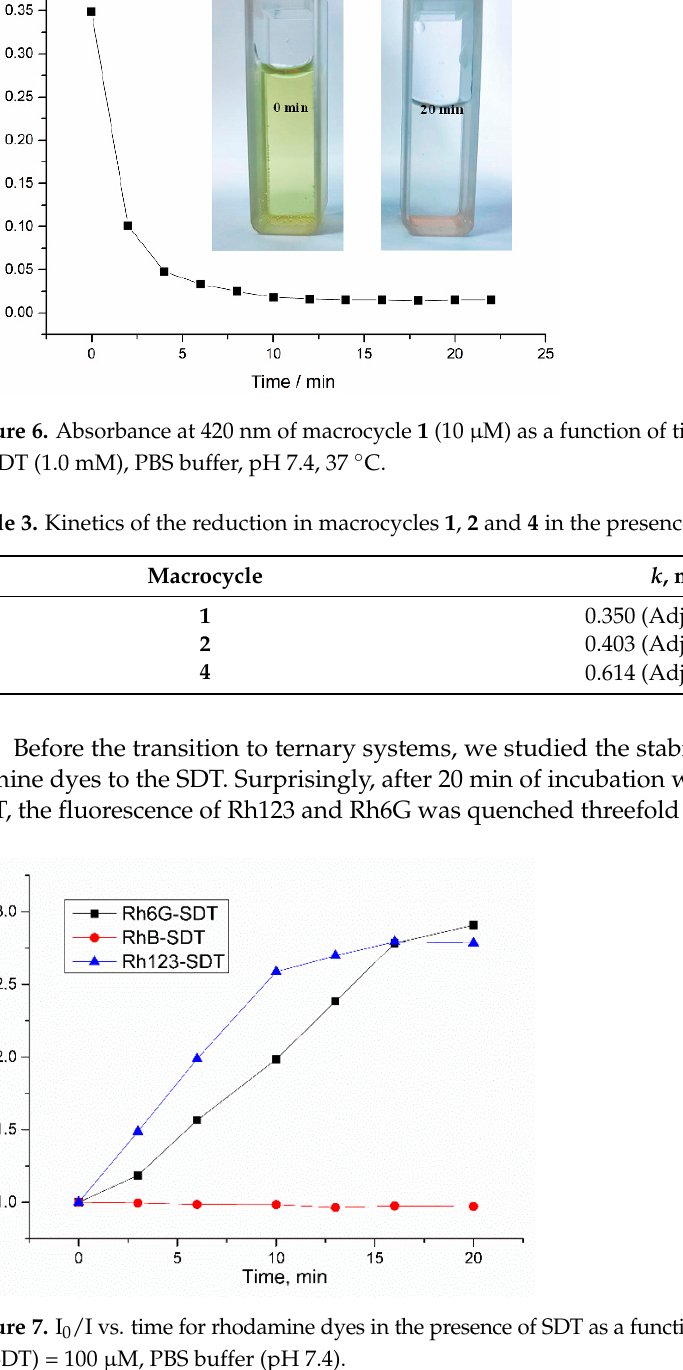
μ M, C (SDT) = 100 μ M, PBS buffer (pH 7.4).